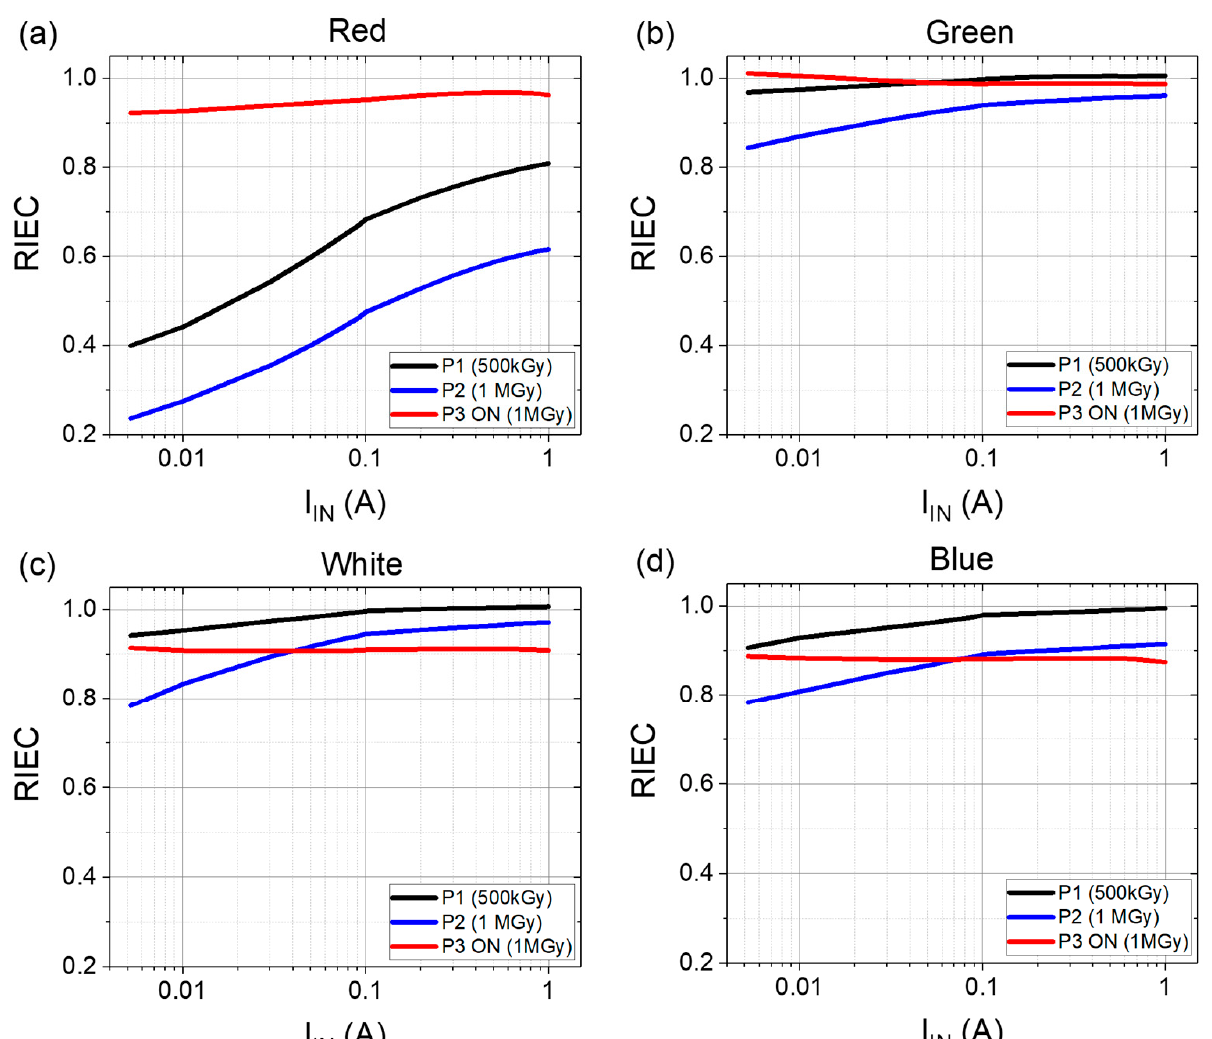
Figure 8. Radiation-induced efficiency change in the P1, P2 and P3 samples, divided by color. Red ( a ), green ( b ), white ( c ) and blue ( d ).